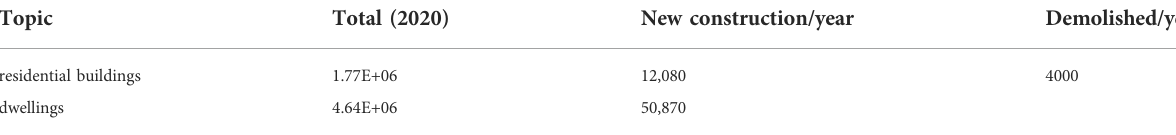
TABLE 1 Overall fi gures of buildings and dwellings in Switzerland (OFS, 2021). For new construction the values correspond to the average fi gures for the 4-year period from 2016 to 2019.